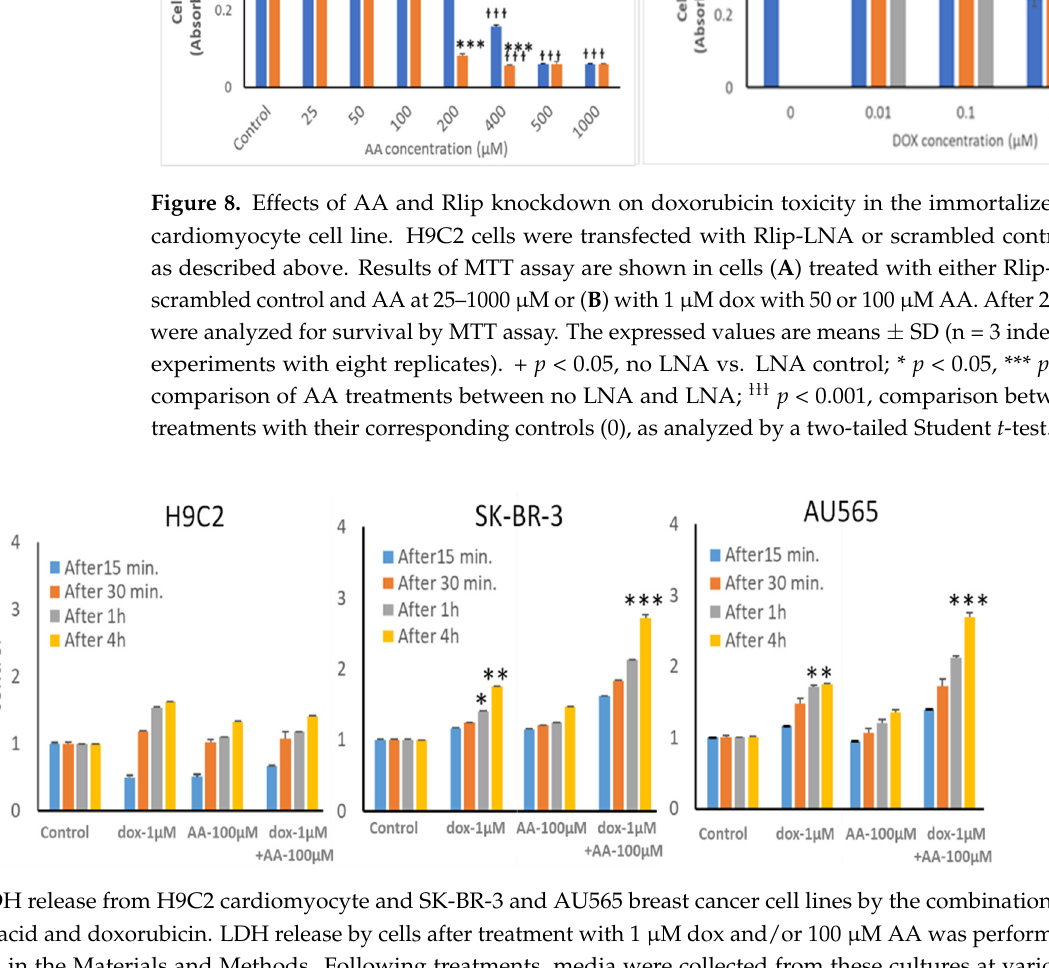
Figure 8. Effects of AA and Rlip knockdown on doxorubicin toxicity in the immortalized H9C2 cardiomyocyte cell line. H9C2 cells were transfected with Rlip-LNA or scrambled control LNA as described above. Results of MTT assay are shown in cells ( A ) treated with either Rlip-LNA or scram- bled control and AA at 25–1000 µM or ( B ) with 1 µM dox with 50 or 100 µM AA. After 24 h, cells were analyzed for survival by MTT assay. The expressed values are means ± SD (n = 3 independent experiments with eight replicates). + p < 0.05, no LNA vs. LNA control; * p < 0.05, *** p < 0.001, comparison of AA treatments between no LNA and LNA; ƚƚƚ p < 0.001, comparison between AA treatments with their corresponding controls (0), as analyzed by a two-tailed Student t -test.